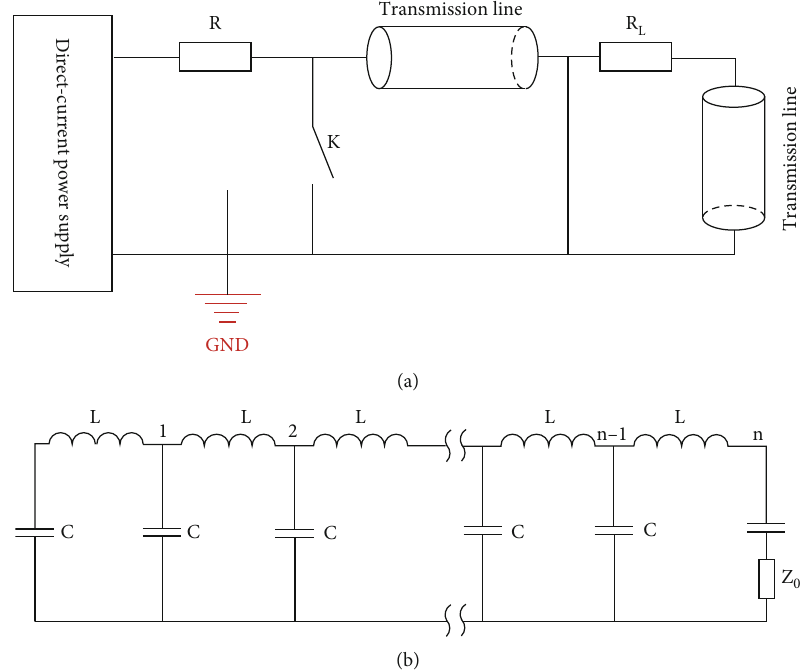
Figure 1: The pulse generator adopts Blumlein transmission line principle. As shown in Figure 1(a), when the closing switch K is not closed, the voltage of the DC supply charges the two transmission lines. After the charging is completed, the switch K is closed, and the energy is released to the load. When the impedance matches, the duration of the pulses loaded on the load is twice the propagation time of the electromagnetic wave in a single transmission line, and the amplitude of the pulse is the value of the charging voltage. In order to achieve adjustable pulse duration, a pulse formation network (Figure 1(b)) is adopted to simulate the two transmission lines, whose pulse ffiffiffiffiffiffi p LC duration is 2 n , where n is the series of equivalent inductance ( L ) and equivalent capacitance ( C ).